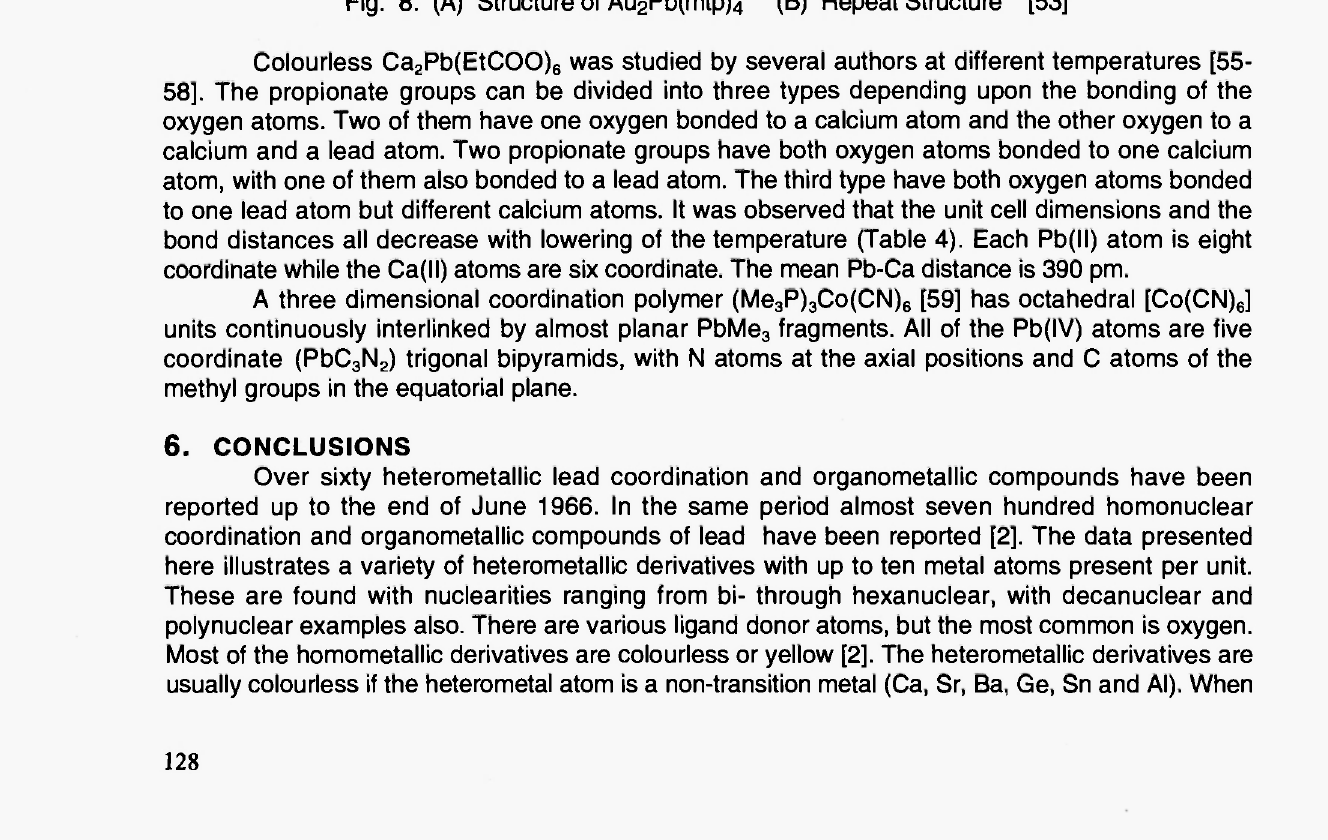
Fig. 8. (A) Structure of Au